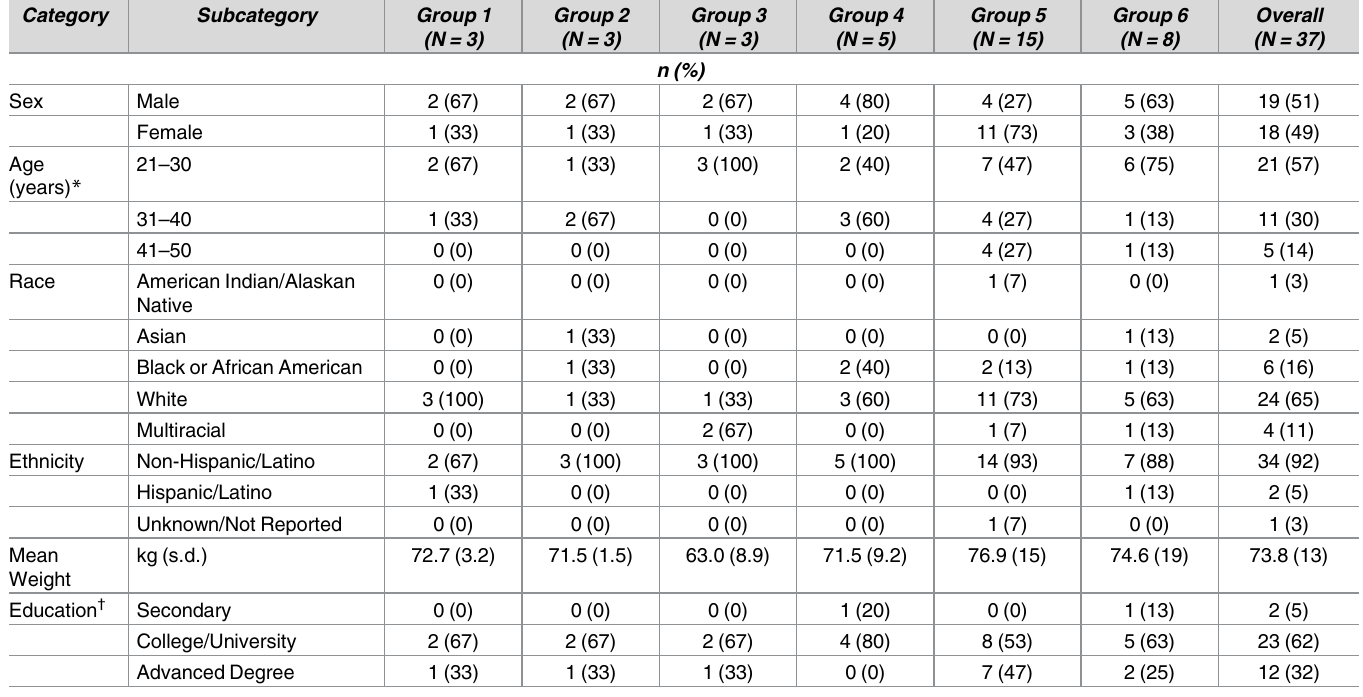
Table 1. Demographic characteristics of study